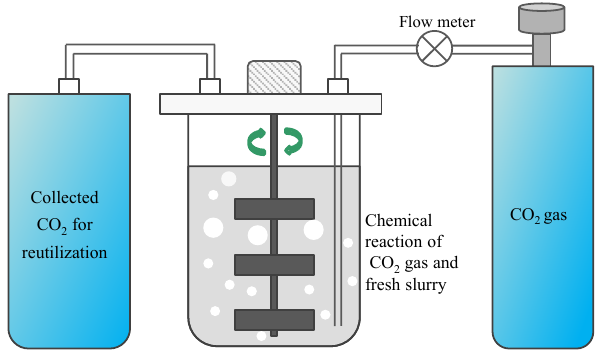
Figure 4. The chemical reaction between CMFB slurry and CO 2 is carried out under stirring.